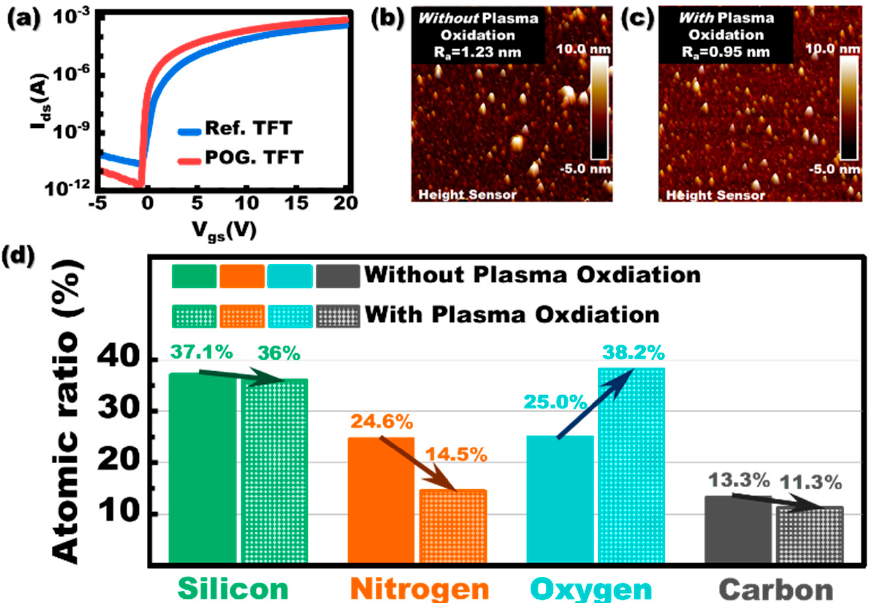
Figure 2. ( a ) Transfer characteristic curves for Ref. TFT and POG. TFT. The surface morphology for SiN x ( b ) without plasma oxidation and ( c ) with plasma oxidation. ( d ) The atomic ratio for the surface of SiN x thin film without/with plasma oxidation. Table 1. Electrical parameters for InGaZnO TFT with/without SiN x surface plasma